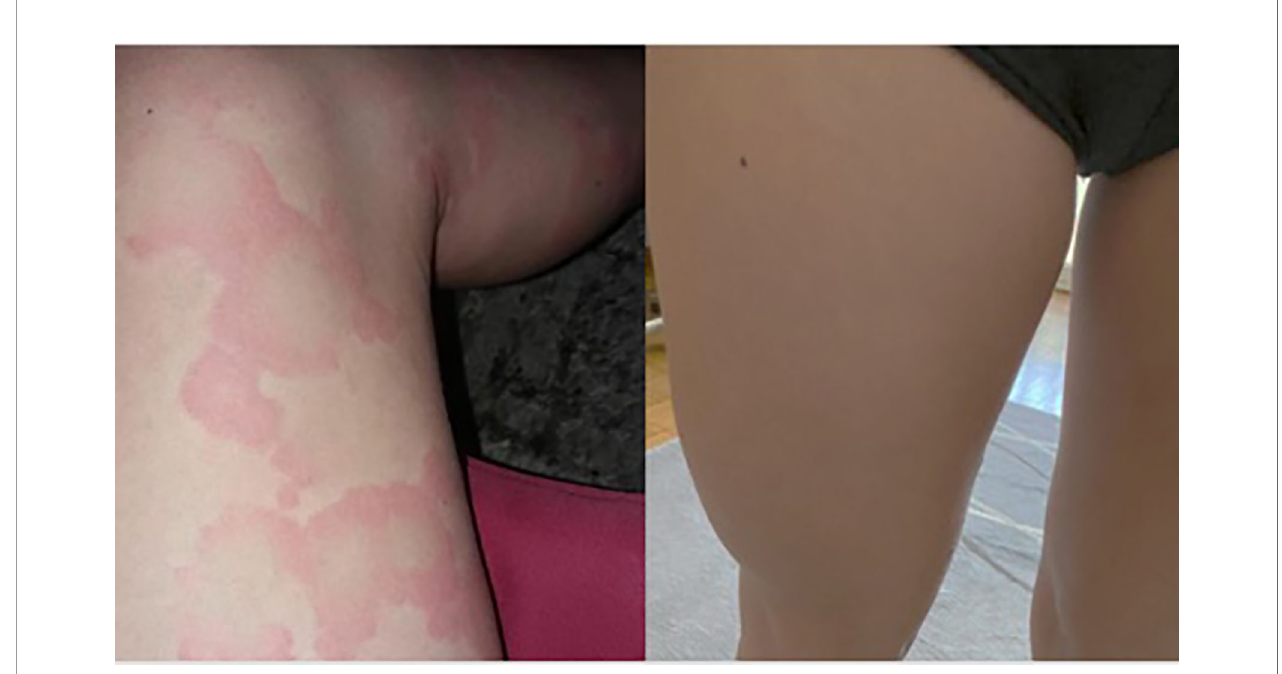
FIGURE 1 | Cutaneous symptoms before and after treatment with